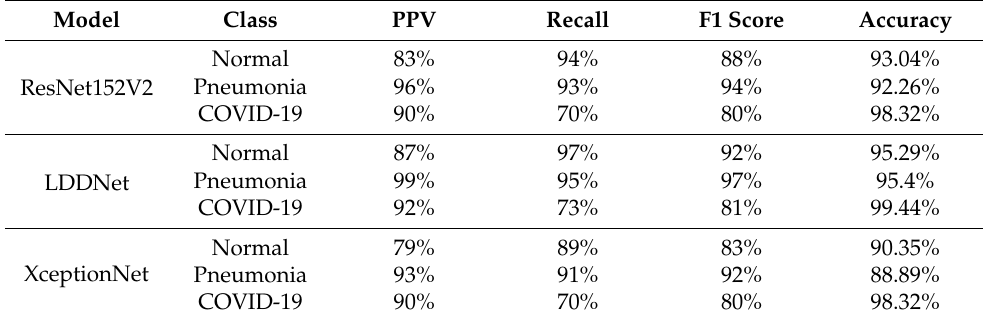
Table 10. Comparison of the different DL models for the SGD